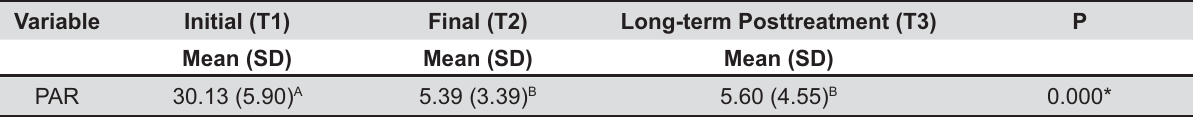
Table 3- Comparison of the occlusal statuses at the three stages (repeated measures ANOVA followed by Tukey tests)